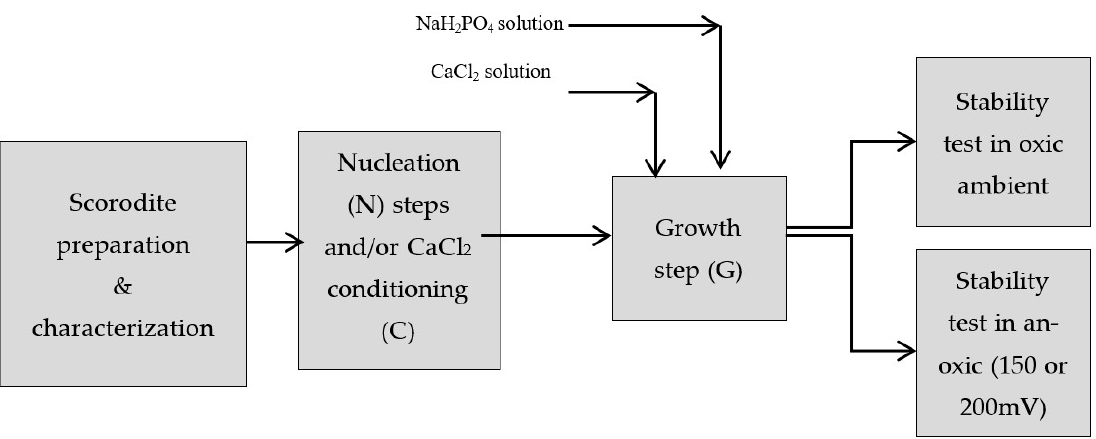
Figure 1. Experimental methodology for scorodite encapsulation and arsenic stability evaluation.